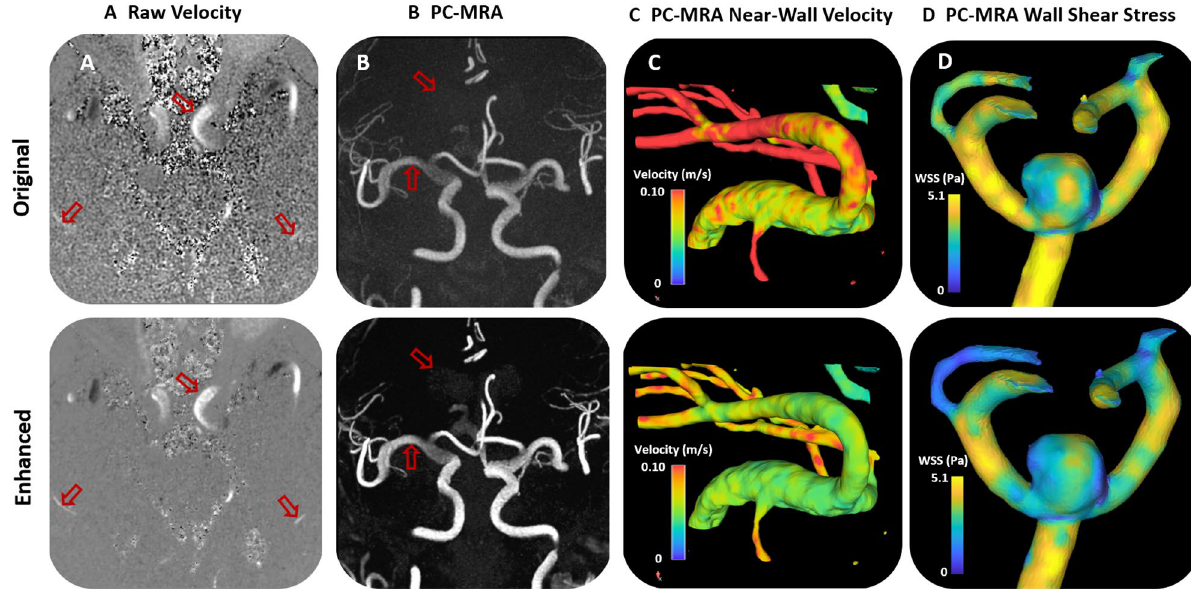
Figure 5. Patient cerebral flow MRI results. ( a ) Cerebral 4D flow MRI raw velocity images before and after trained network application. ( b ) Phase-contrast MR angiogram images before and after trained network application. ( c ) Near wall velocity contours displayed on cerebrovascular segmentations before and after network application. ( d ) Wall shear stress plots on a cerebral aneurysm wall. Arrows note key areas of image